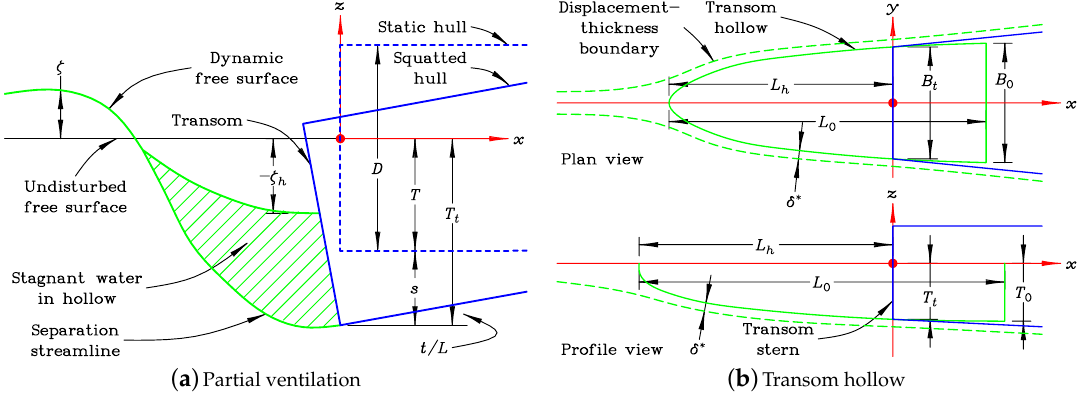
Figure 5. Hydrodynamic modeling of the transom